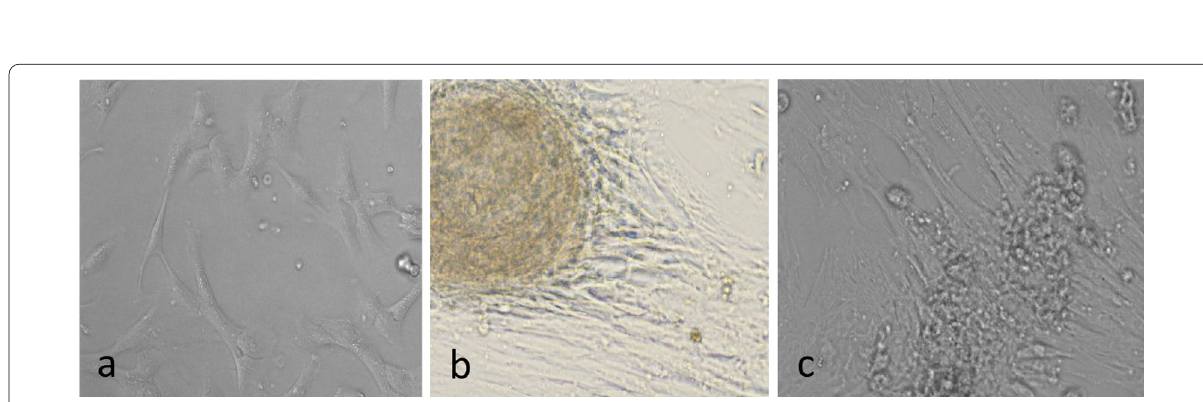
Fig. 5 Morphological features of stem cells grew in culture medium with Gibco’s NBCS: a After 10–12 days of primary culture, spindle-shaped fibroblast-like cells appear as seen under phase contrast microscope Olympus 1X73 under 20X magnification. b Sprouting and cell growth after 4 weeks and above observed under 20X magnification c On 6–8 weeks observed under 20X